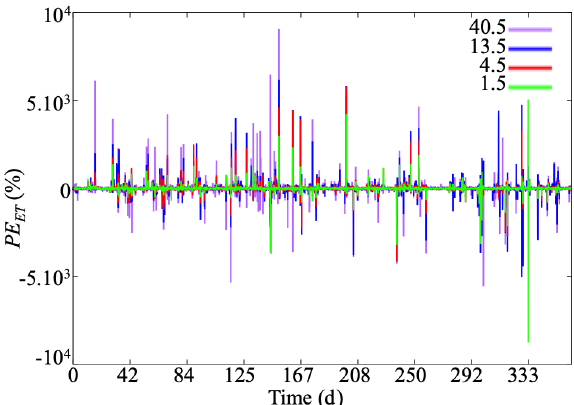
Figure 5. Temporal variation of the percent error of evapotranspi- ration PE ET obtained with meteorological forcing at spatial reso- lutions of 1.5, 4.5, 13.5, and 40.5km relative to the highest spatial resolution of meteorological forcing